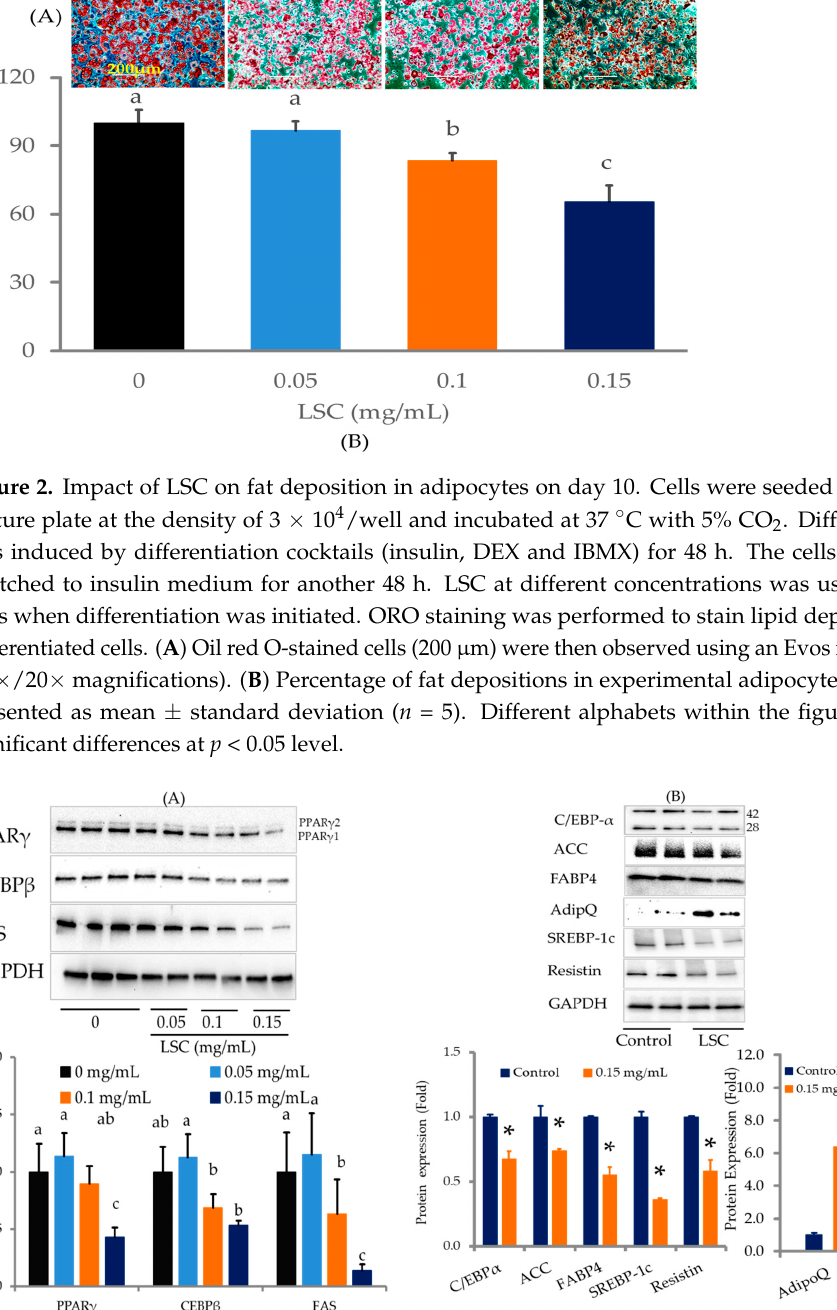
Figure 3. Effects of LSC on adipogenesis and lipogenesis in 3T3-L1 cells on day 10. Proteins were extracted with protease and phosphatase inhibitors and quantified using BCA on day 10. Proteins were separated by SDS-PAGE. PPAR- γ , C/EBP- β , C/EBP- α , and SREBP-1c; lipogenic proteins such as FAS, and ACC, insulin sensitizer adiponectin (AdipoQ) in insulin resistance-inducing proteins such as FABP4 (aP2) and resistin were detected with speci fi c antibodies using Western blot. Protein intensity was quanti fi ed with ImageJ software, 1.49 versions (32bit).( A ) Preliminary screening of key adipogenic and lipogenic proteins expression changes in experimental cells. ( B ) Impact of selected concentration of LSC on other proteins involved in adipogenesis and lipogenesis. Results are ex- pressed as mean ± standard deviation of three replicates ( n = 3). * p < 0.05. Di ff erent alphabets in the fi gure indicate signi fi cant di ff erences at p < 0.05.